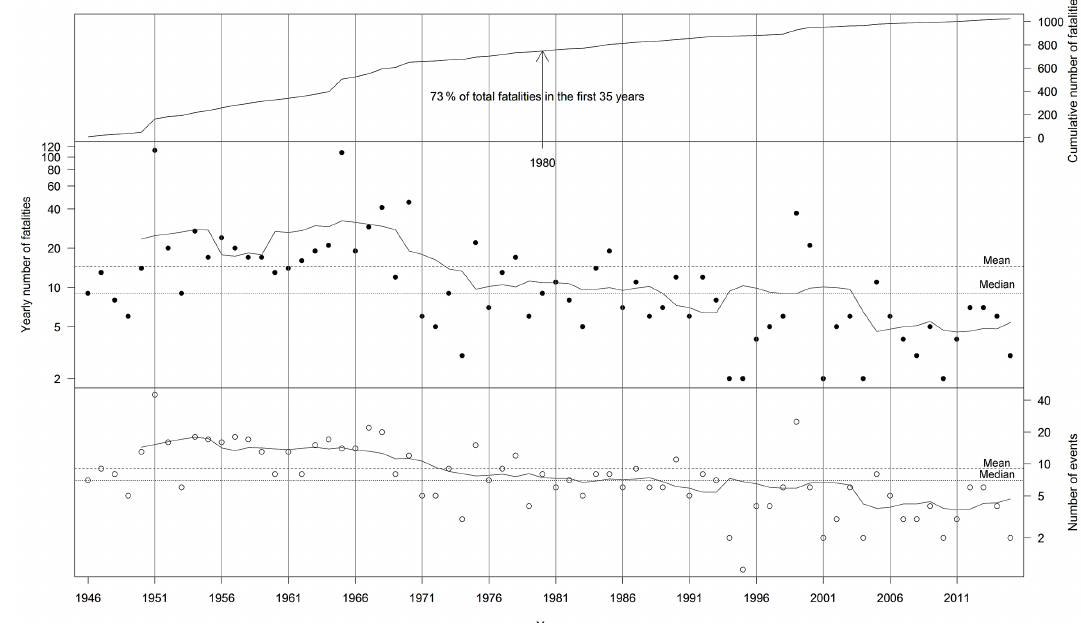
Figure 2. Total number of natural hazard deaths in Switzerland from 1946 to 2015. Cumulative number of fatalities (top) and annual frequency of fatalities (middle). At the bottom of the figure, the number of fatal natural hazard events is displayed. The dashed and dotted horizontal lines in the middle and bottom panels indicate the mean and median annual fatality frequencies and mean and median annual event frequencies, respectively. The thin grey lines in the middle and bottom panels show a 10-year running